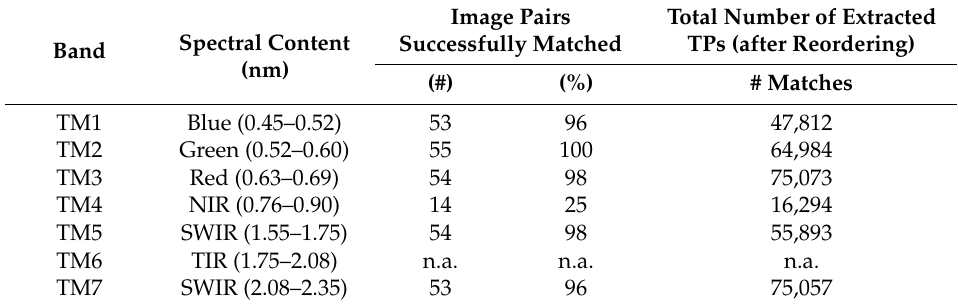
Table 4. Summary of TPs extracted in ‘Multan’ dataset with their multiplicity for both automatic data processing (MIRA) and manual measurement. Here results obtain in spectral Band TM3 are reported. TPs are considered with their multiplicity as re-projected on the space of the ‘master’ image. Number of Matched TPs in Band TM3 # Images MIRA